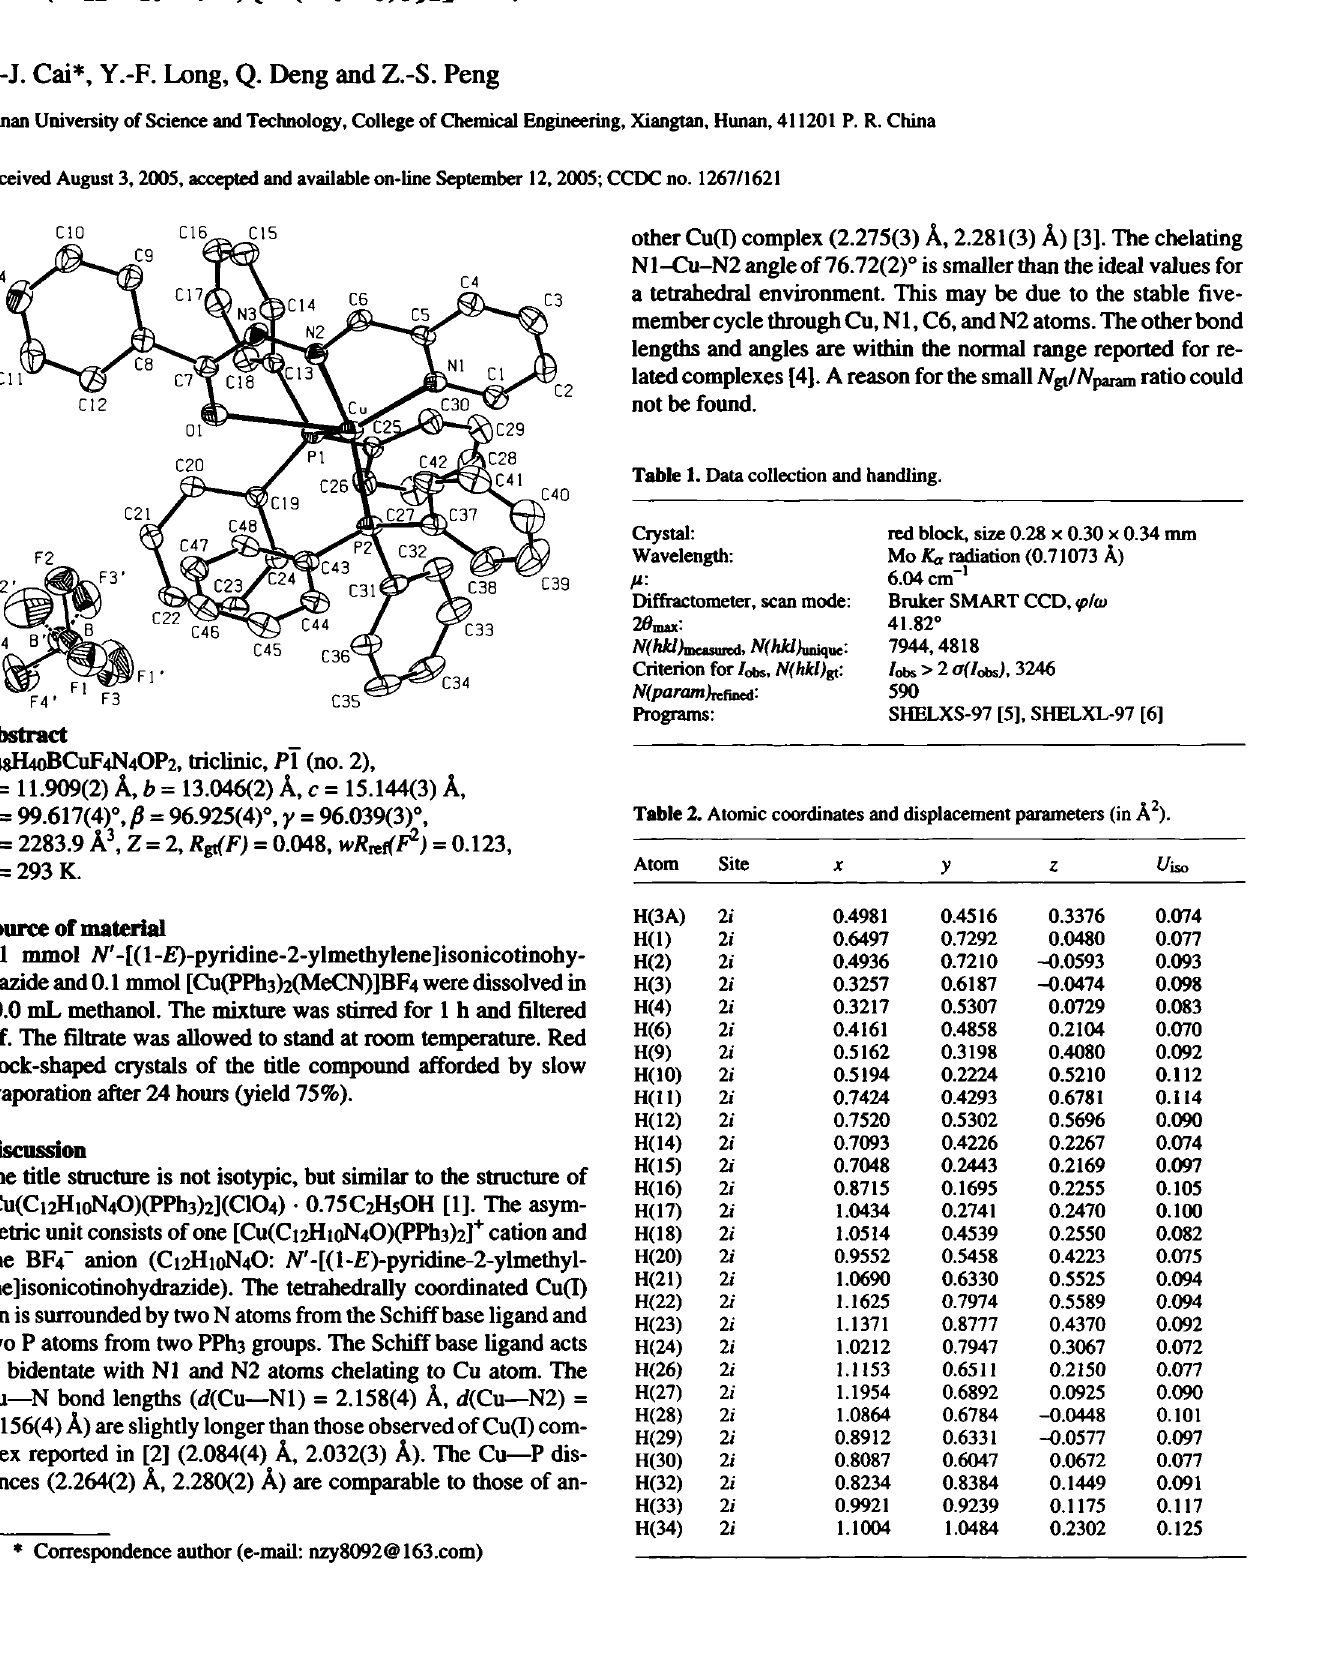
Table 1. Data collection and handling.